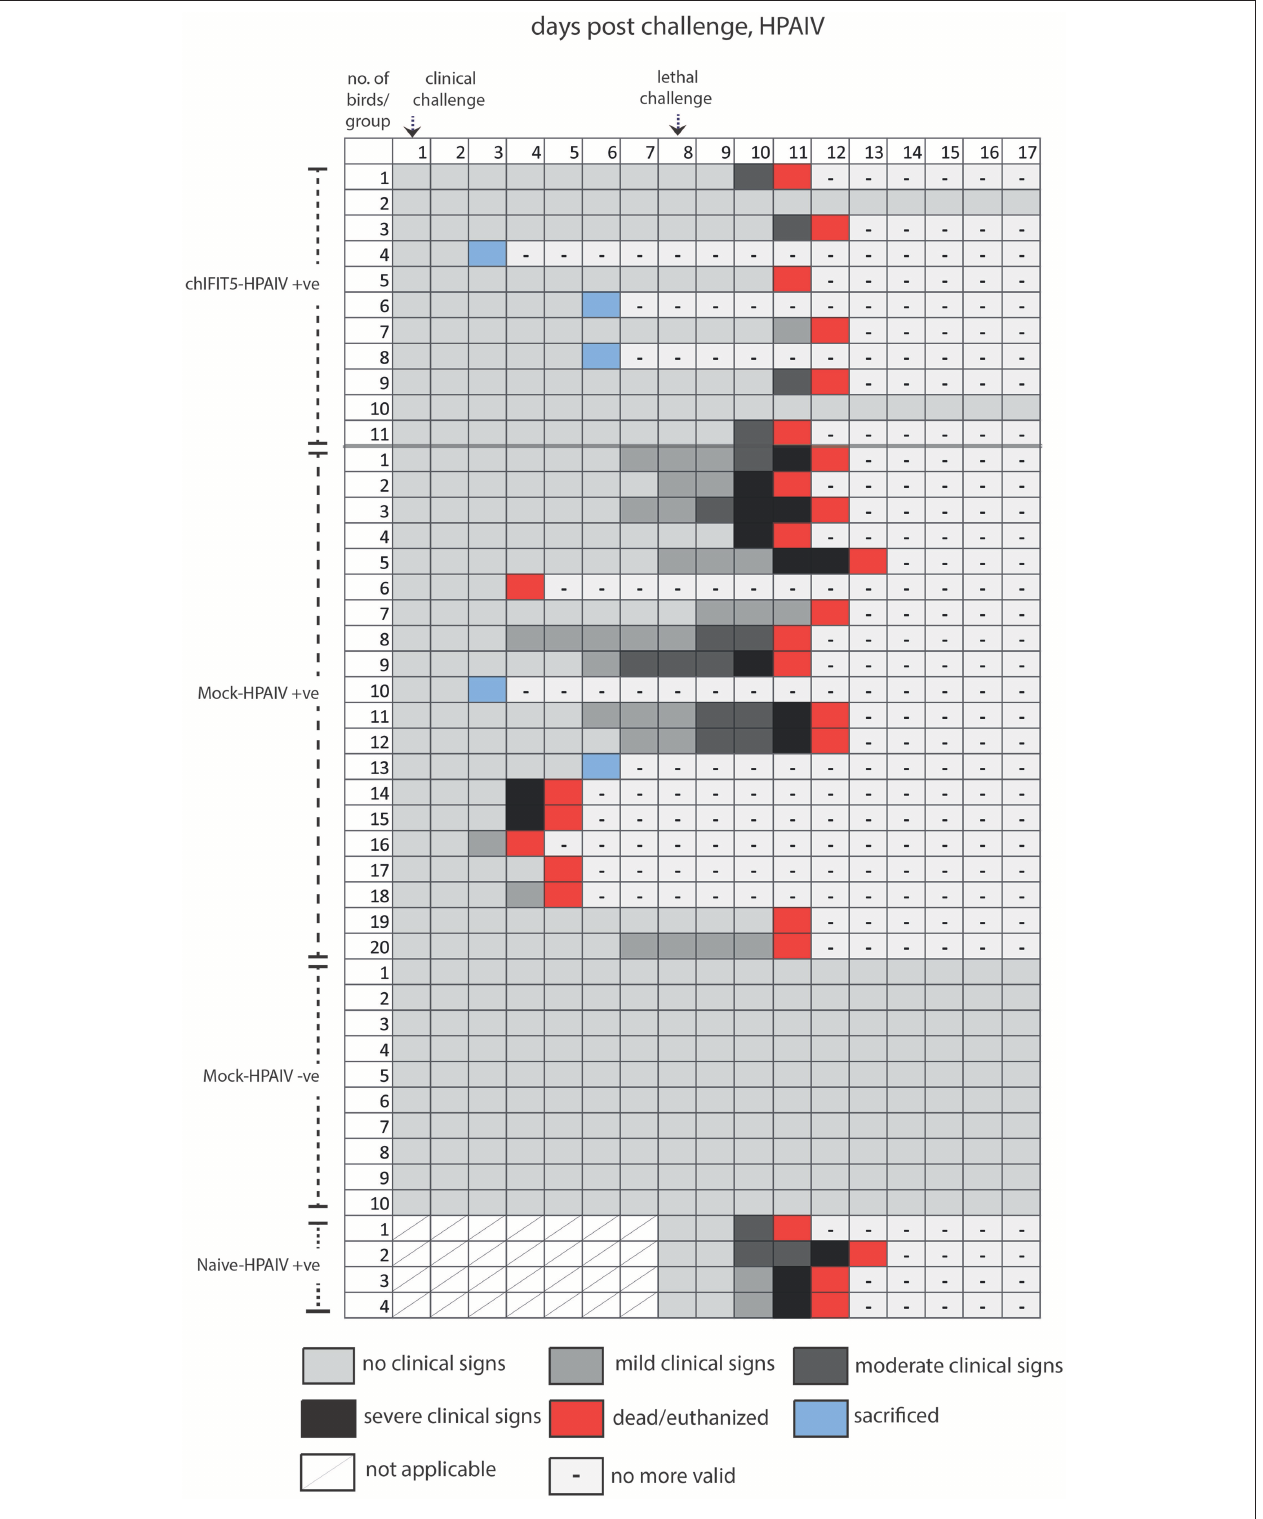
FIGURE 4 | Clinical signs of individual chicken in different groups pre- and post-clinical and lethal challenge induced by the HPAIV.